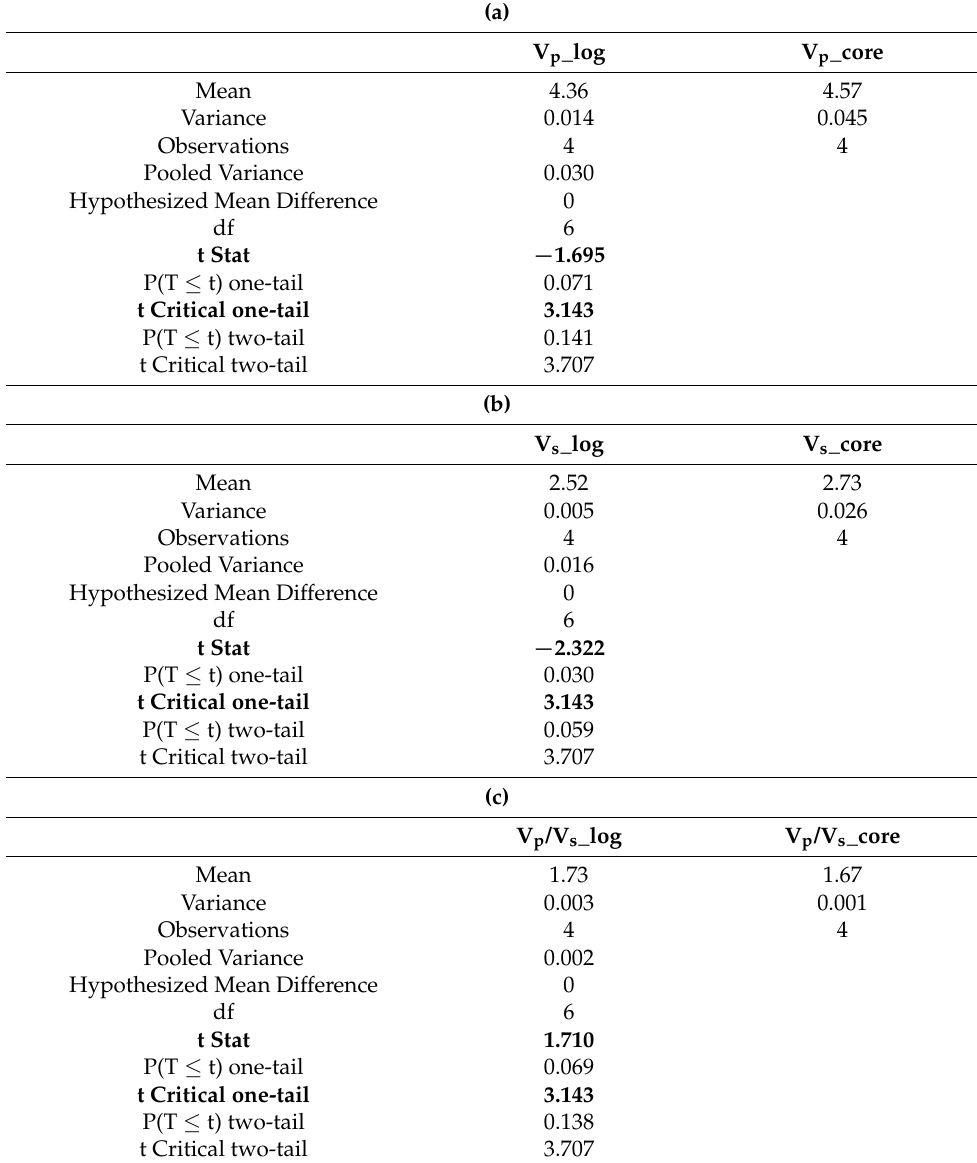
Table 7. (a) Student t -test for the co-located sonic log and ultrasonic core P-wave velocity measure- ments (after fluid substitution to in situ saturations) in the lower Spraberry shale formation, Midland basin. The result indicates there is no significant difference between the mean of the sonic log and ultrasonic core measurements. (b) Student t -test for the co-located sonic log and ultrasonic core S-wave velocity measurements (after fluid substitution to in situ saturations) in the lower Spraberry shale formation, Midland basin. The result indicates there is no significant difference between the mean of the sonic log and ultrasonic core measurements. (c) Student t -test for the co-located sonic log and ultrasonic core V p /V s ratio (after fluid substitution to in situ saturations) in the lower Spraberry shale formation, Midland basin. The result indicates there is no significant difference between the mean of the sonic log and ultrasonic core velocity